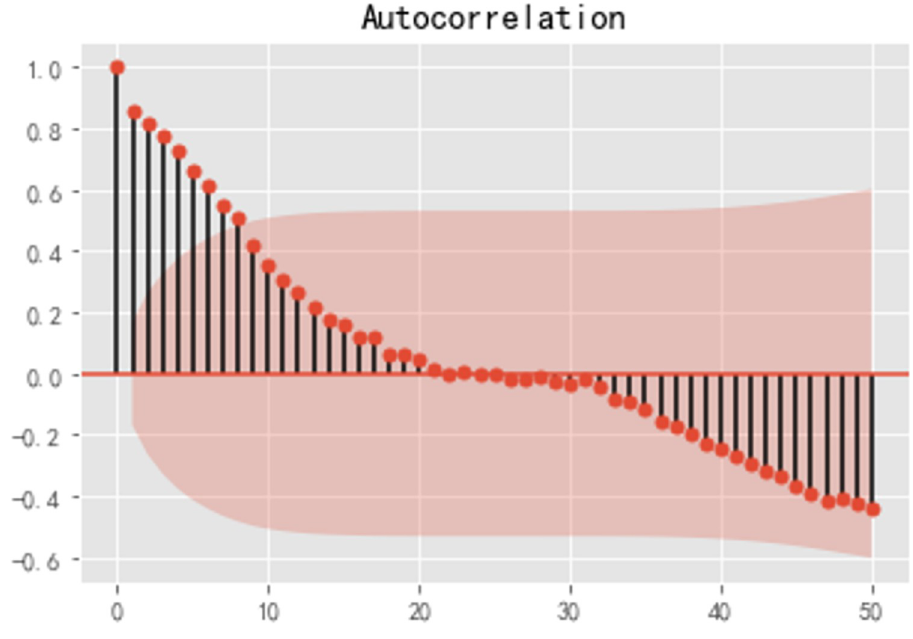
Fig 13. Cabbage price